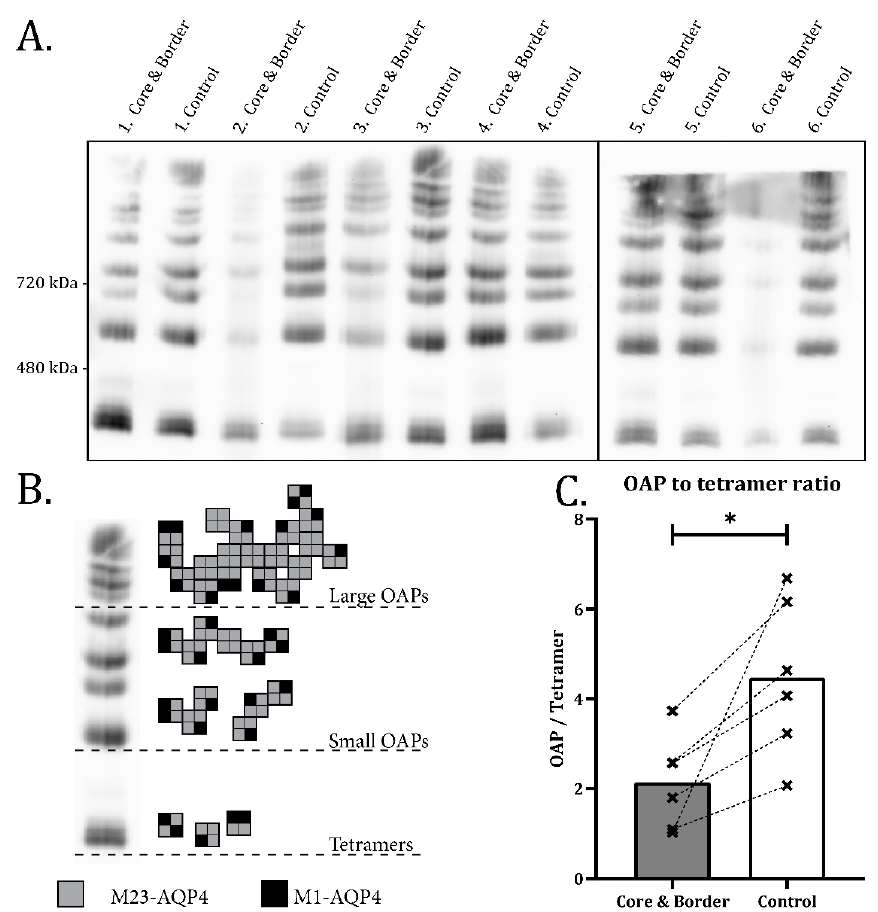
Figure 3. OAP to tetramer ratio is halved in infarct samples revealed by BN-PAGE. ( A ) BN-PAGE of infarct (including both core and immediate border zone) and contralateral control samples im- munostained with an anti-AQP4 antibody. ( B ) Illustration showing the separation of tertiary AQP4 structures in BN-PAGE. A tetramer band is followed by bands with higher molecular weight represent- ing OAPs. Large and small OAPs are clearly distinguished in 3–12% gels allowing semiquantitative analysis. ( C ) Individual ratios made by dividing the densitometric values of the small OAP bands by the tetramer band seen in ( B ). Dotted lines connect values from the same animal, asterisk indicates significant difference. Paired Student’s t -test ( n = 6) shows a significant ( p = 0.020) reduction in OAP/Tetramer ratio in infarct samples compared to contralateral control tissue.